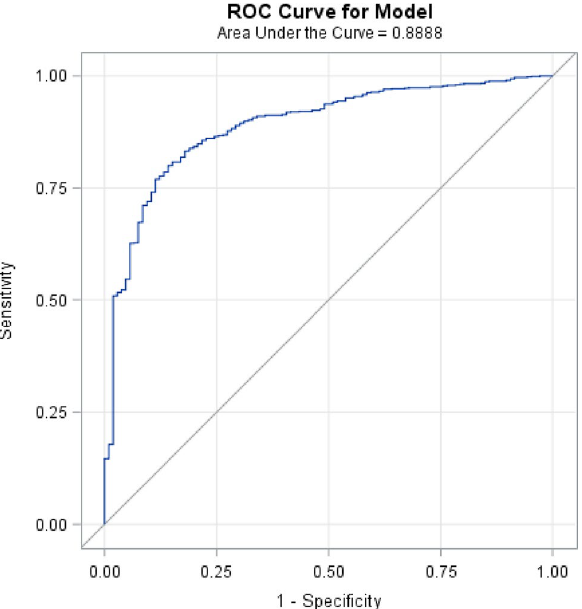
Figure 5. The Receiver Operator Characteristic (ROC) Curve for the revised Safe Sleep Calculator algorithm model applied to the New Zealand pilot population